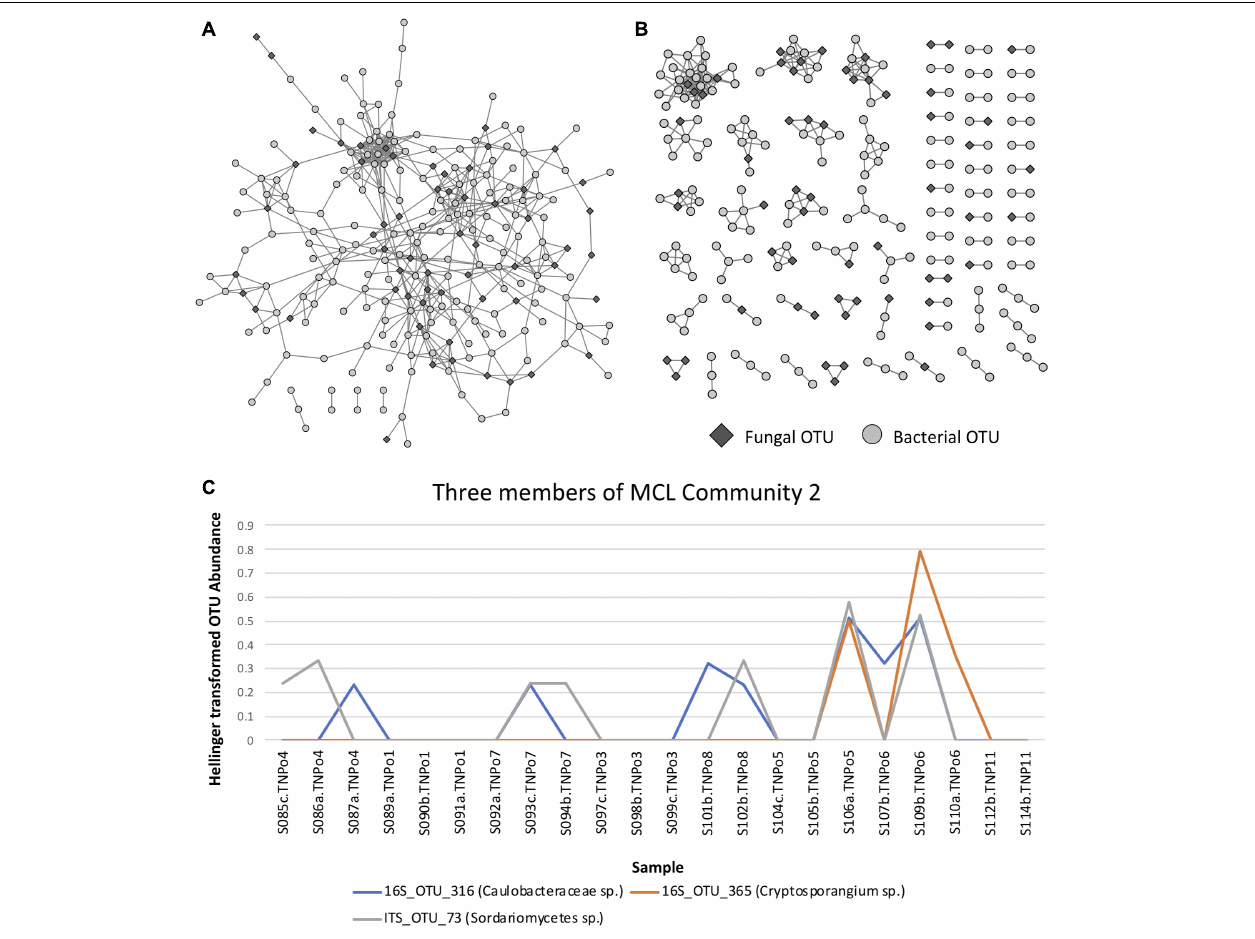
FIGURE 9 | (A) Operational taxonomic unit (OTU) Pearson correlation network for Experiment 2 (soil origin), indicating the correlations between OTUs across samples. (B) Markov Cluster (MCL) community clusters of OTUs constructed from clustering of the network in Figure 9A . (C) Example line plot of 3 OTUs in MCL community 2, illustrating their correlated